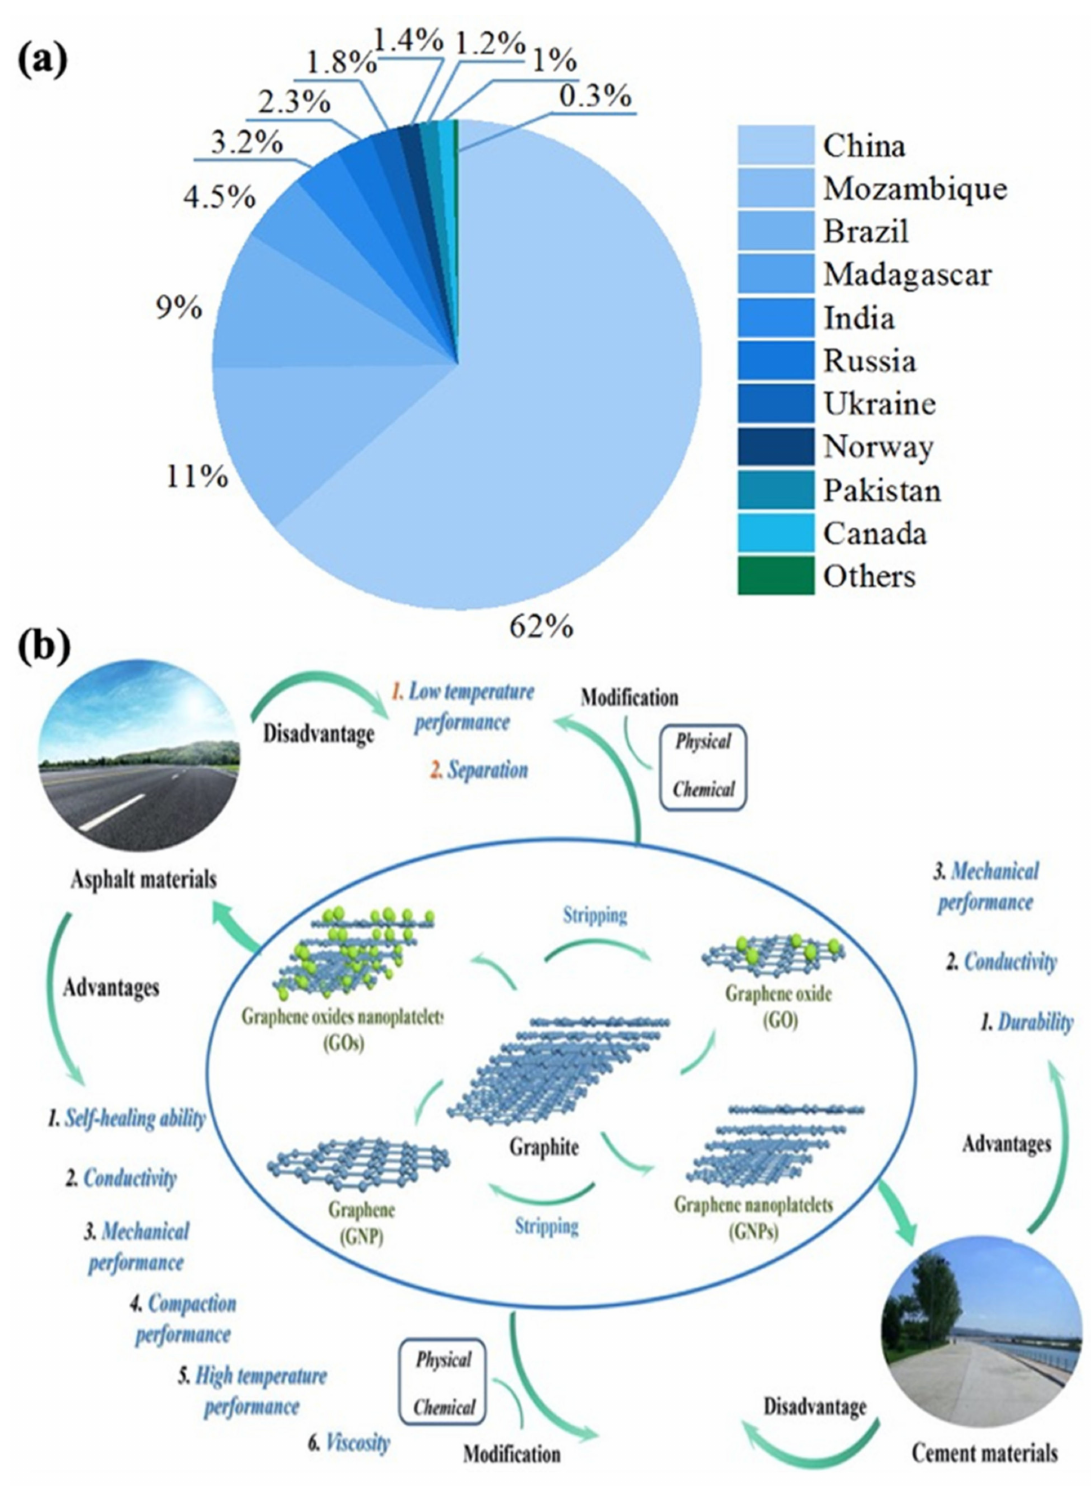
Figure 2. ( a ) Countries as major producers of graphite; ( b ) main applications of graphite-based materials in civil engineering (reprinted from [32] ©2021 with permission from